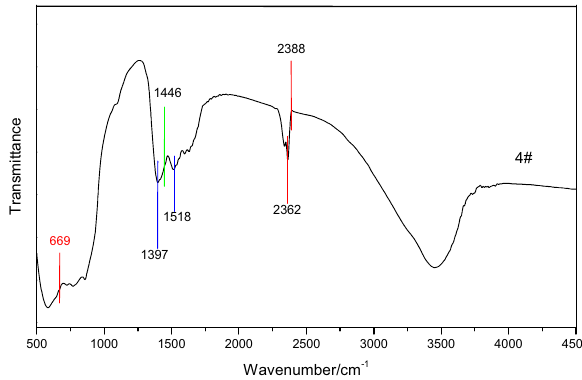
Figure 3: Infrared spectrum of the CO 2 adsorption state of the K/KOH/ γ - Al 2 O 3